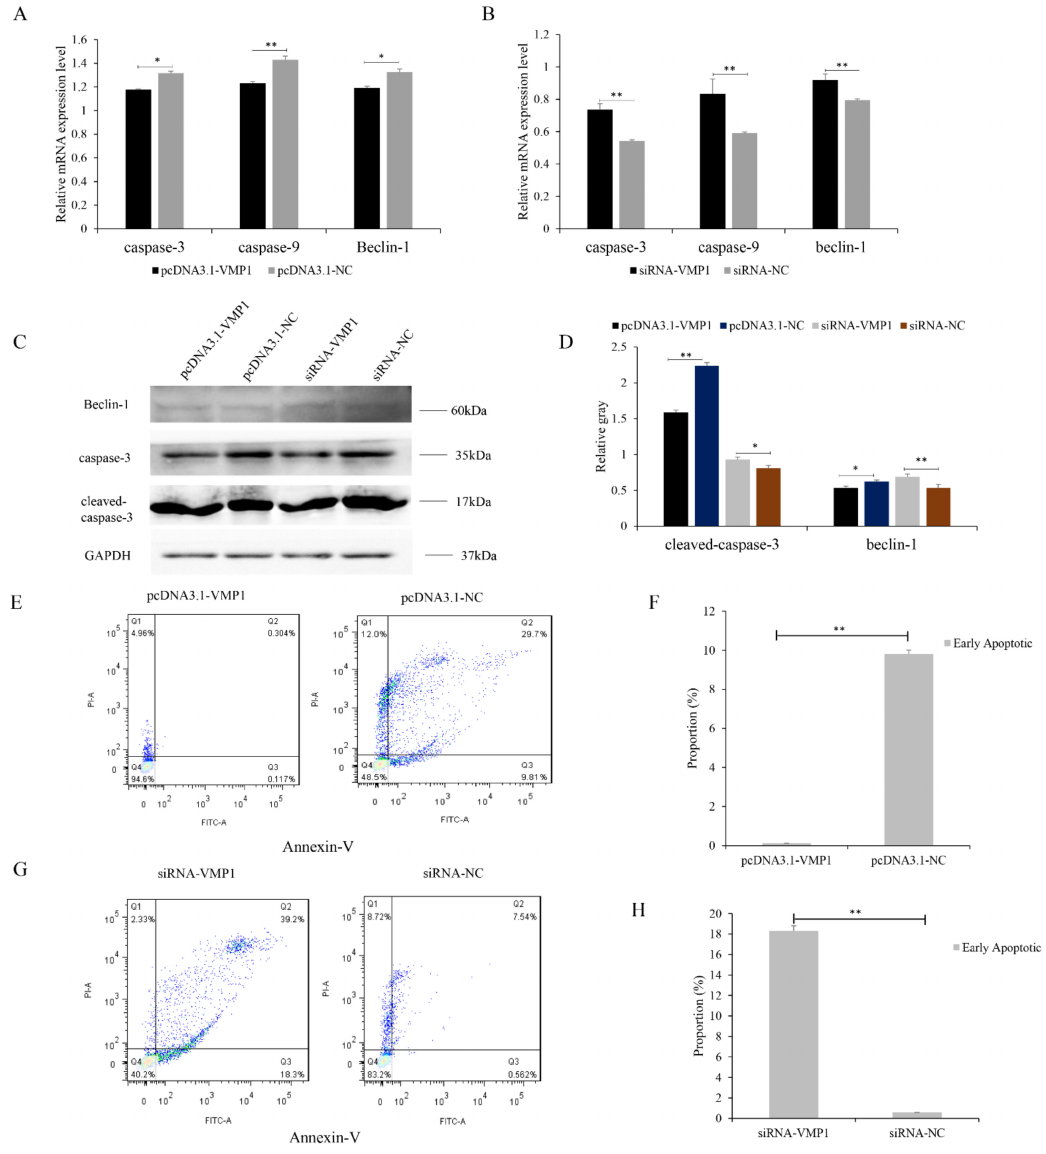
Figure 4. VMP1 regulates apoptosis of goat myoblasts: ( A , B ) Expression levels of apoptosis-related genes (caspase-3, caspase-9, and beclin-1) were quantified by RT-qPCR in myoblasts overexpressing and underexpressing VMP1. ( C , D ) Western blot analysis illustrates the levels of beclin-1 and caspase- 3 cleavage in myoblasts overexpressing and underexpressing VMP1. GAPDH was used as the internal standard. ( E ) Apoptotic myoblasts were identified by flow cytometry. Cells were stained with annexin V–FITC/propidium iodide (PI). ( F ) Percentages of myoblasts in apoptosis. ( G ) Apoptotic myoblasts identified by flow cytometry. ( H ) Percentages of myoblasts in apoptosis. Replicates = 3. Data are presented as means ± SE; * p < 0.05 and ** p < 0.01. NC, negative